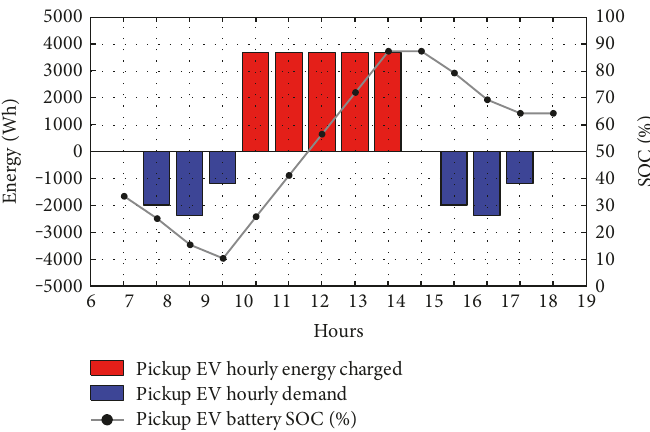
Figure 13: EV charging and discharging process and SOC evolution.